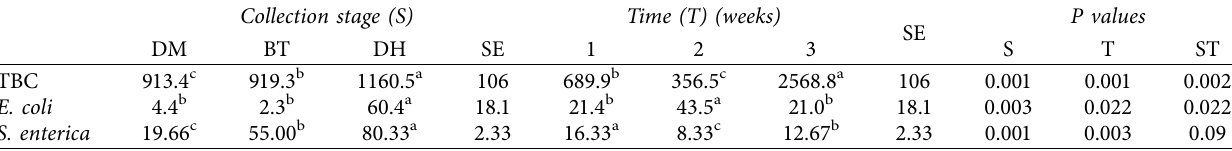
Table 2: LS means of TBC (x1000cfu/mL) E. coli (x1000 cfu/mL) and S. enterica (x1000cfu/mL) of raw milk produced at AU Farm. Collection stage (S)